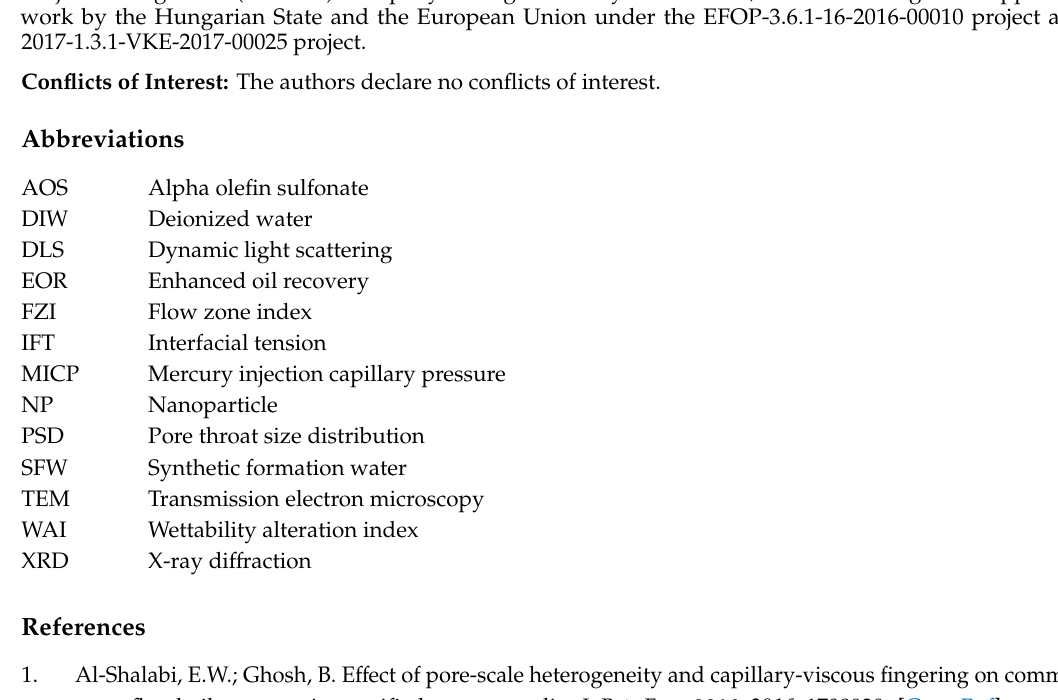
Figure S1: Desiccator used for vacuum saturation of the core plugs, Figure S2: Schematic view of the setup used for USS water / oil relative permeability measurements, Figure S3: Water / oil relative permeability curves, Table S1: Routine core specifications and conditions of the water / oil relative permeability test, Table S2: The results of USS oil / water relative permeability test, Table S3: Parameters of the Modified Corey